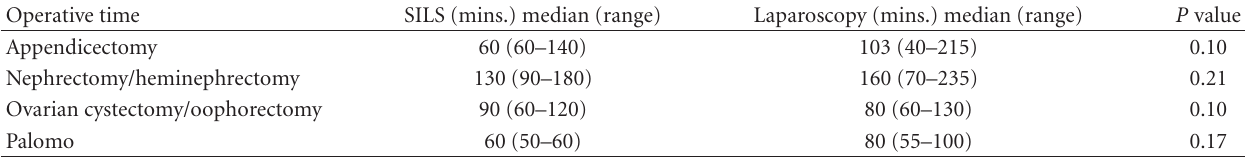
Table 2: Comparison of operative time, median